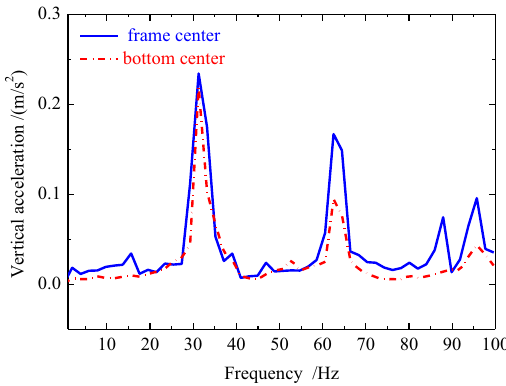
Fig. 10 The vertical acceleration frequency–history curves of at- ground structure